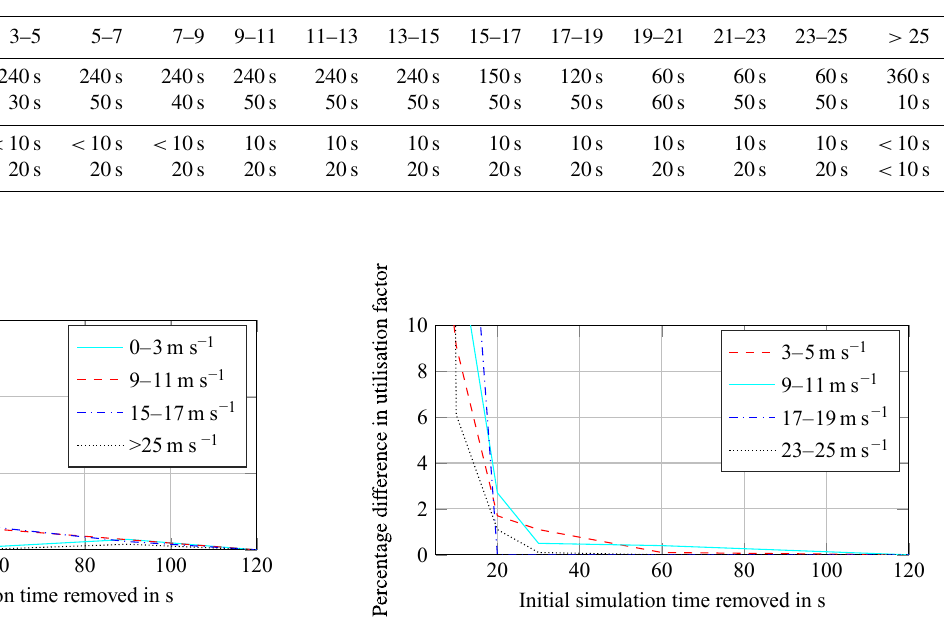
Figure 17. Initial transient behaviour of the wind turbine with a jacket substructure for different wind speeds. Percentage difference in the utilisation factor (ULS) compared to the “converged” value